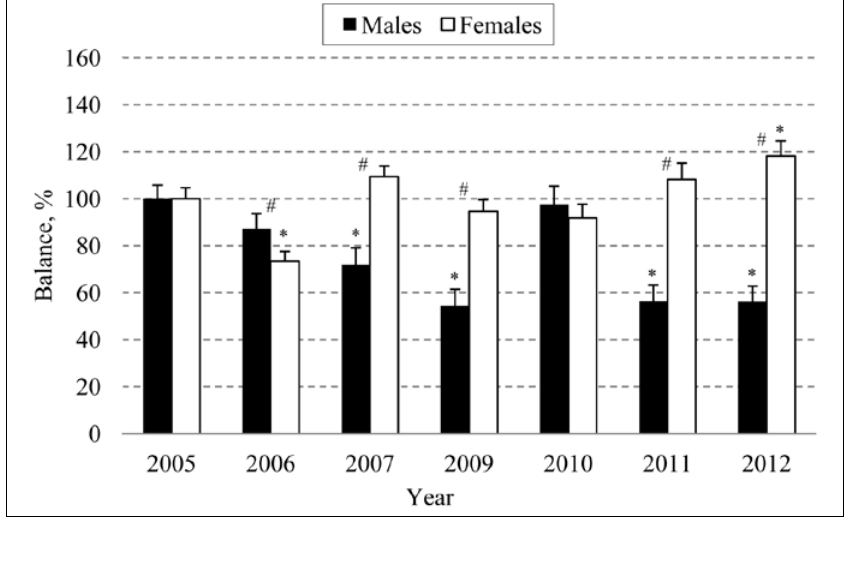
Figure 3. Trunk flexion test results of males and females